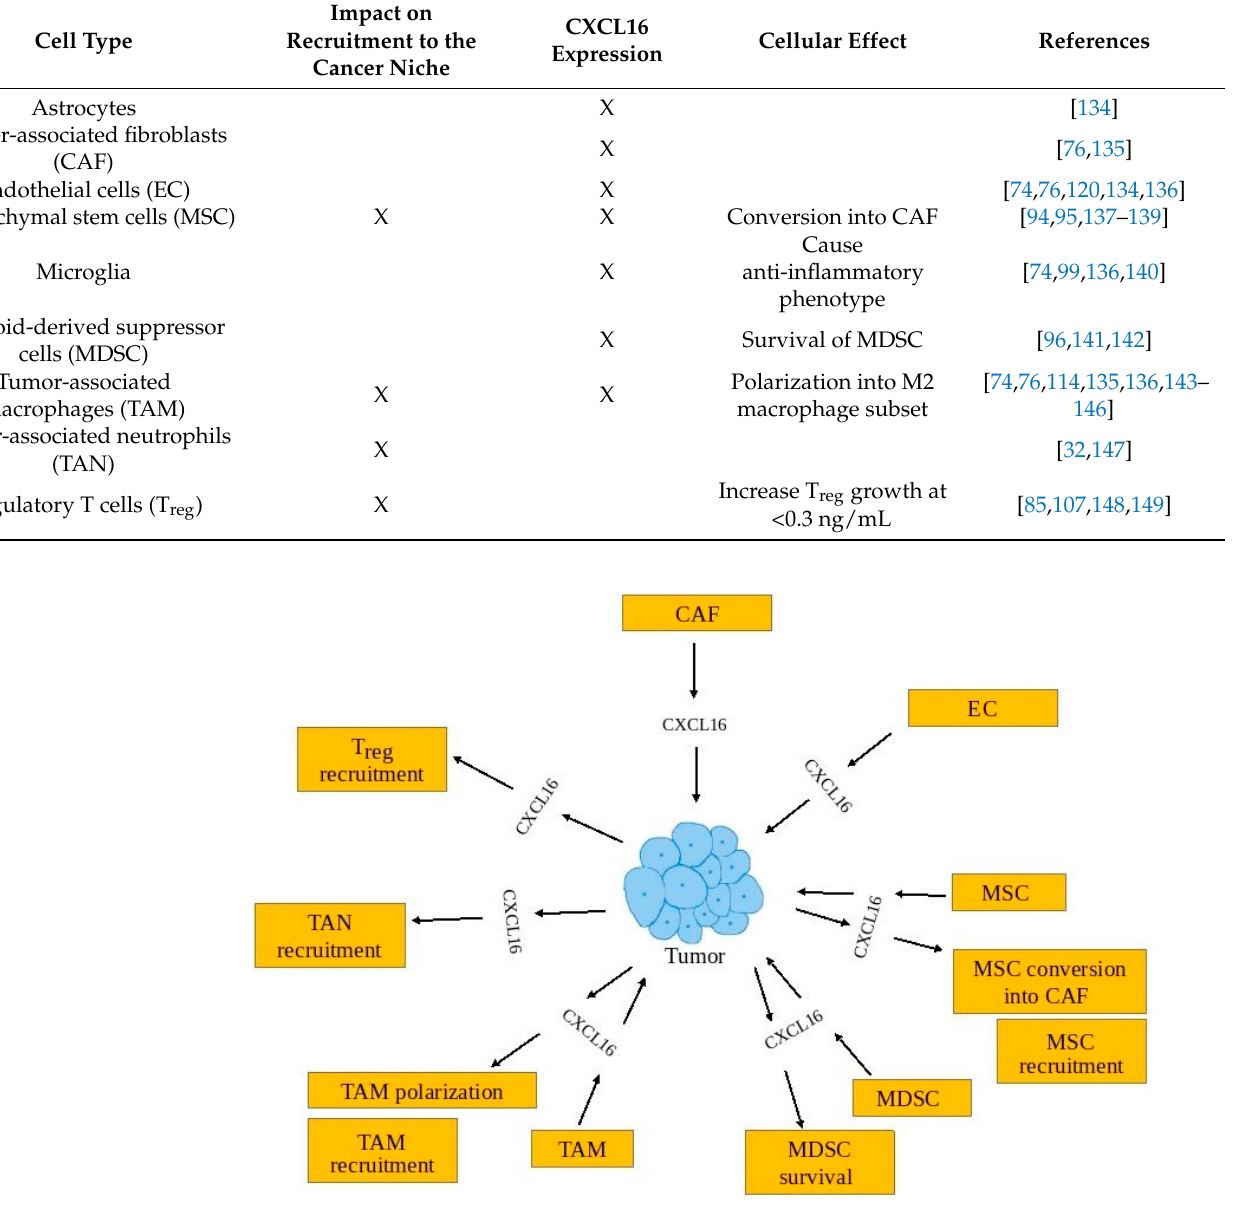
Figure 4. In the tumor, CXCL16-mediated intercellular communication creates multiple relationships between various cells. CXCL16 is produced not only by tumors but by tumor-associated cells, including CAF, EC, MSC, MDSC, and TAM. CXCL16 also influences tumor-associated cells. It causes recruitment of MSC, TAM, TAN, and T reg into the tumor niche. CXCL16 also causes TAM polarization, MDSC survival, and MSC conversion into